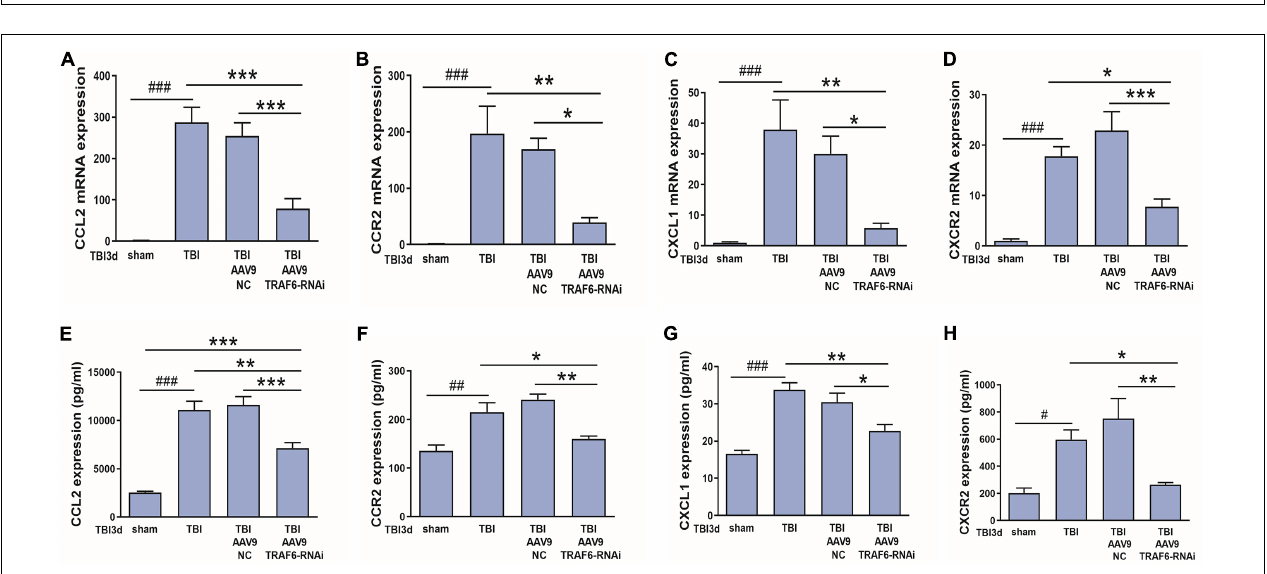
FIGURE 6 | TRAF6 knockdown reduced p-NF- κ B, p-ERK, p-JNK, and p-p38 expression in the injured cortex after TBI. (A) Western blot analysis was used to detect the expression of p-NF- κ B, p-ERK, p-JNK, and p-p38. GAPDH was used as an internal control. (B–E) The optical density of the bands was analyzed by ImageJ. * P < 0.05, ** P < 0.01, and *** P < 0.001 vs. AAV9-TRAF6-RNAi group. ## P < 0.01 and ### P < 0.001 vs. sham group.